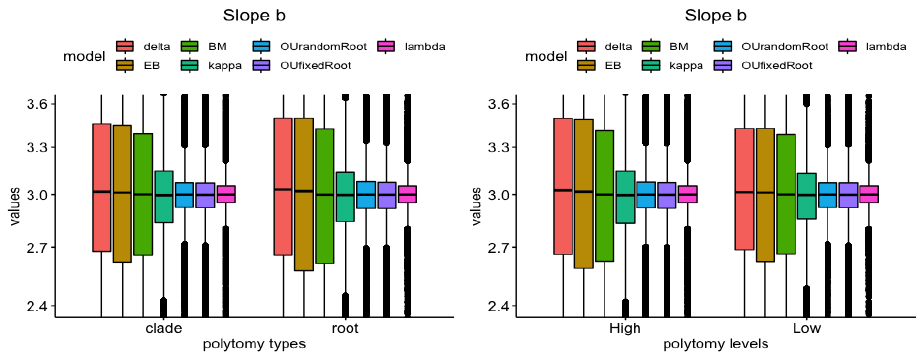
Figure 16. Regression slope estimation concerning different models and polytomy types. Left panel : polynomial type vs. models. Right panel : polynomial level vs. models.